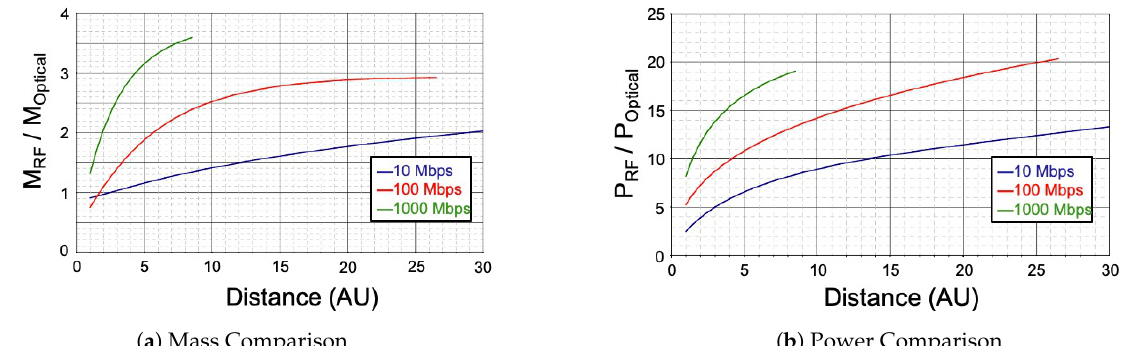
Figure 1. Comparison between optical and RF communications systems in terms of: ( a ) mass and ( b ) power, over various distances and bit rates (after